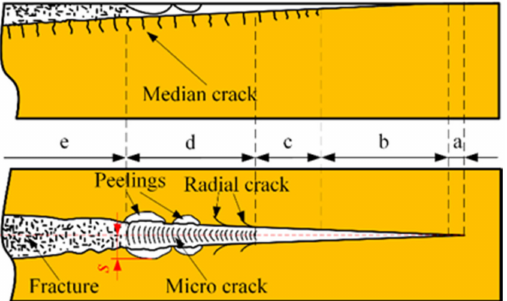
Figure 2. Schematic diagrams of scratching for brittle materials using an increasingly linear load along the scratch track, where “a” represents the elastic stage, “b” the represents plastic stage, “c” represents the subsurface cracking stage, “d” represents the surface and subsurface cracking stage, and “e” represents the microabrasive